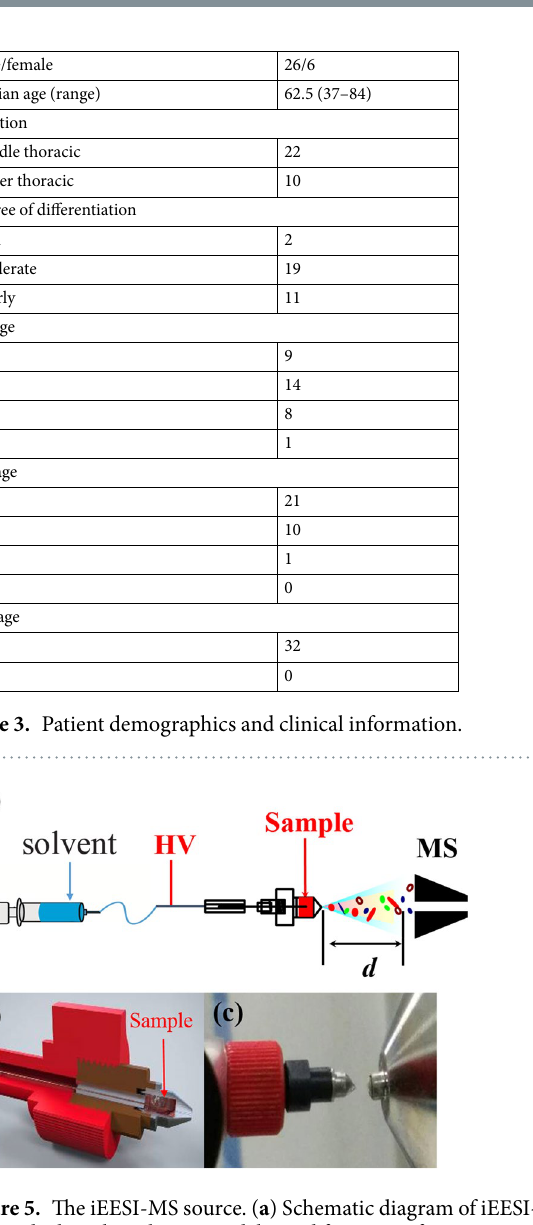
was calculated using the remaining data. Withheld data were projected into the new model and classified as one tissue type, performed between the unknown sample point and calculated class centres. This process was repeated for each individual patient. First, mass spectrometric data were normalized using standard normal variate trans- formations to correct for baseline shifts and global variation in signal intensities, cancer and normal tissue data were analysed by PLS, and the key amino acids and small molecules that had the most influence on the separation between sample classes were identified. Then, ROC curves of some key chemicals and the areas under the curve (AUC) of the ROC were calculated using SPSS version 21.0 (SPSS, Chicago, IL, USA), and then used to assess the validity of the potential small molecular biomarkers and to identify the optimized cutoff values.